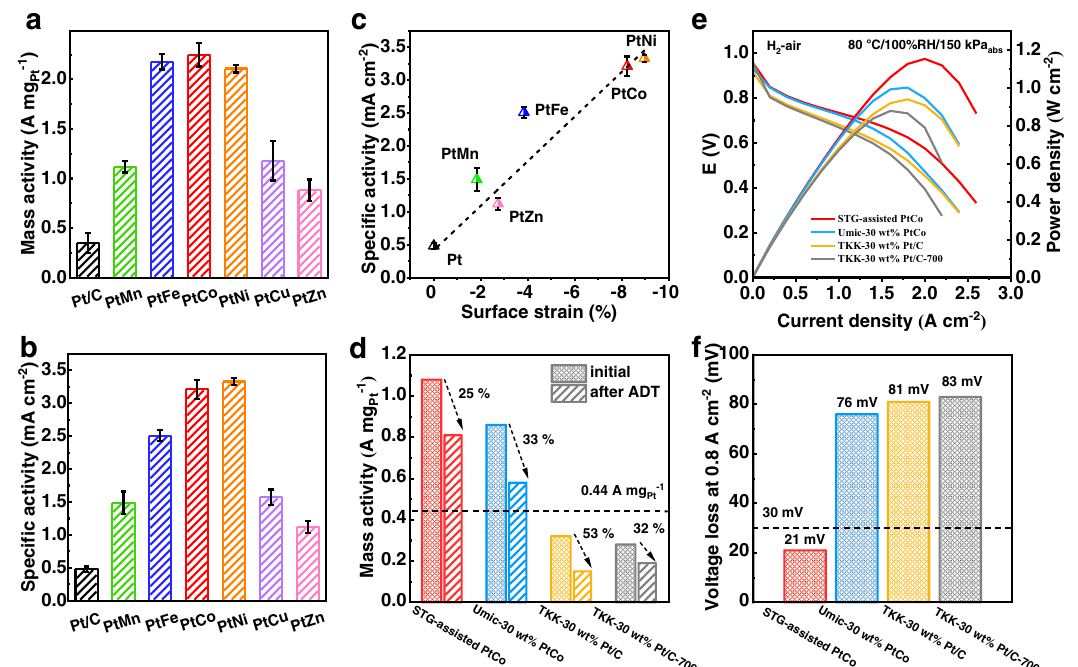
Fig. 6 | Electrocatalytic performance. RDE mass activity ( a ), and speci fi c activity ( b ) of the STG-assisted Pt-IMCs catalysts and TKK-30 wt% Pt/C. The Pt loading in RDEtestswere intherangeof11~13 µ gcm – 2 . c Correlationbetween speci fi c activity andcalculatedsurfacestrainofthe fi veL1 0 PtMcatalystsandPt/C.Theerrorbarsin a , b ,and c wereobtainedafterthreeparallelexperiments. d Massactivitylossofthe MEAs made with cathode catalysts of STG-assisted PtCo, Umic-30 wt% PtCo, TKK- 30 wt% Pt/C, and TKK-30 wt% Pt/C-700 after 30,000 cycles ’ ADT. e H 2 -air polar- izationcurvesand powerdensity plotsoftheMEAsmadewithcathodecatalystsof